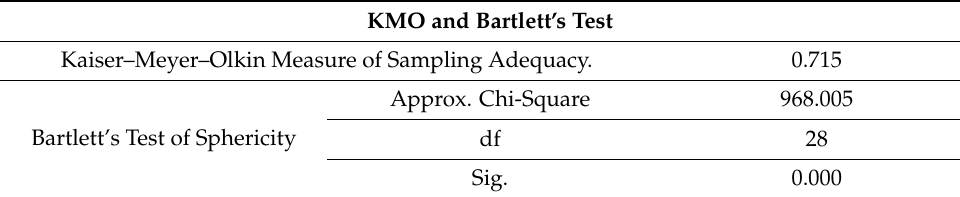
Table 3. Results of the KMO test and Bartlett’s